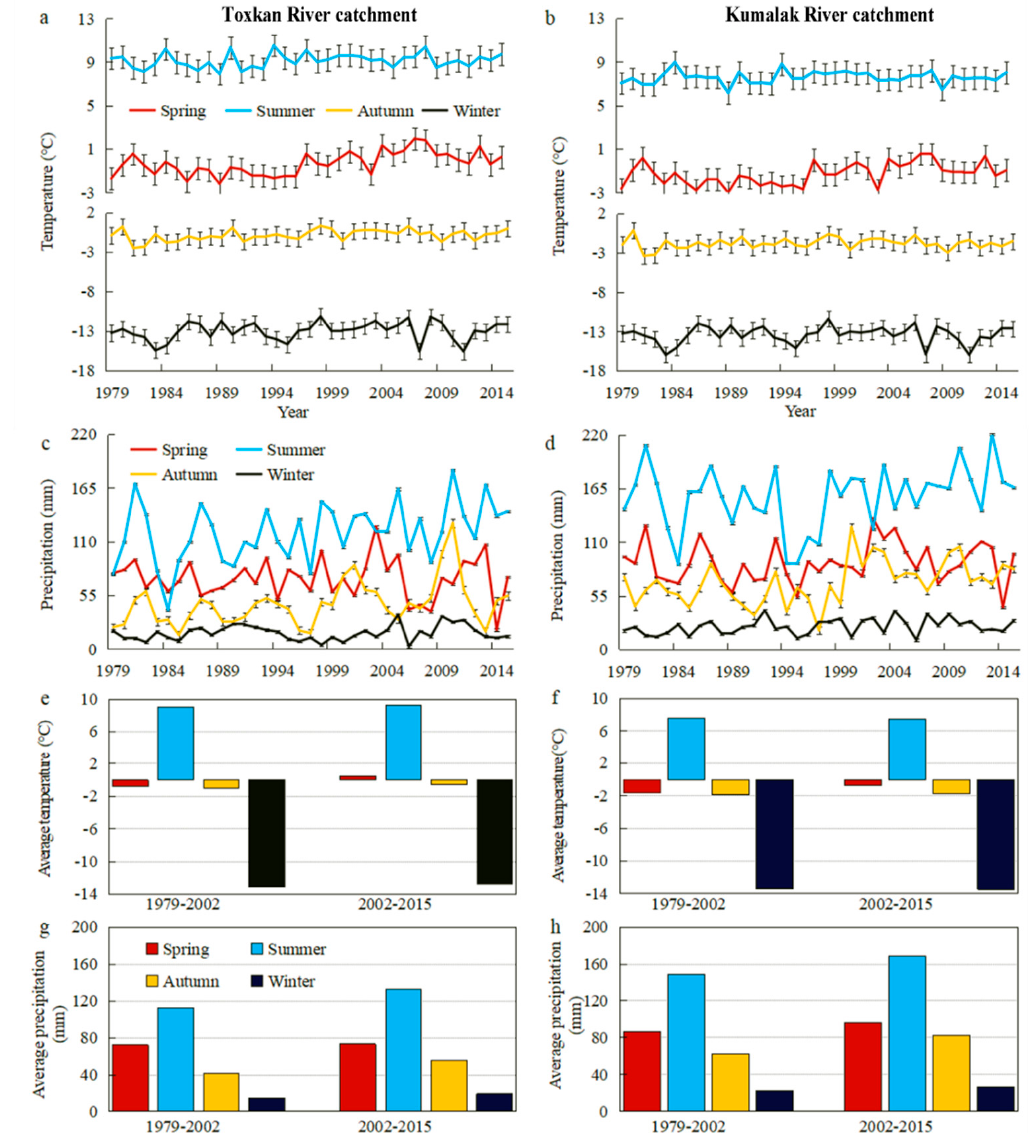
Figure 3. Multi-annual means of seasonal temperature and precipitation in the Toxkan and Kumalak River catchments during 1979–2015. ( a , b ) Multi-annual means of seasonal temperature ( c , d ) average seasonal precipitation during 1979–2015; ( e – h ) average seasonal temperature and precipitation during 1979–2002 and 2002–2015.